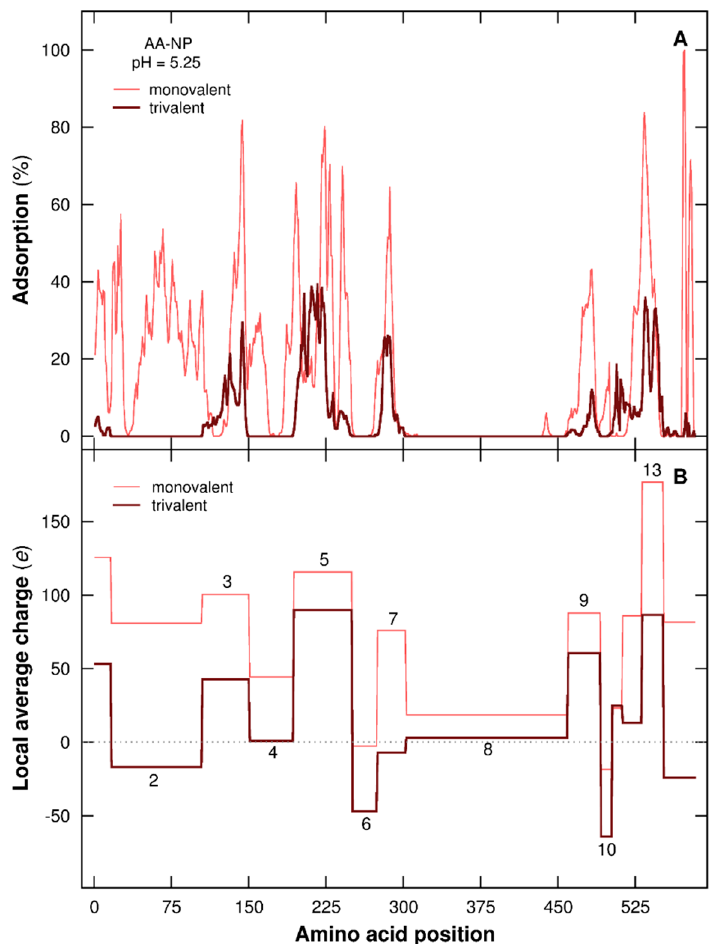
Figure 9. ( A ) Mean adsorption of each chain AA within the NP adsorption layer (in percentage), and ( B ) local charges per PP segment (in elementary charges). σ is − 60 mC/m 2 and pH 5.25. Monovalent and trivalent salt are considered (ionic strength 1 × 10 − 4 M). Domains 1–14 in ( B ) based on the adsorbed/desorbed PP domains in ( A ) considering monovalent salt. The same intervals are taken into account considering trivalent salt cations for comparison.